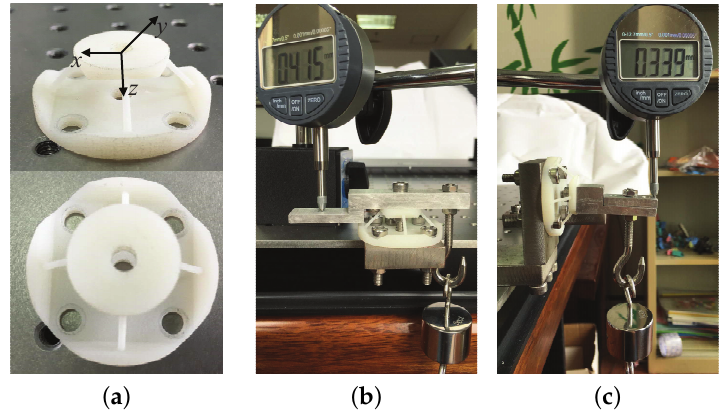
Figure 8. The experimental setups. ( a ) Photo of the prototype, and experimental conditions of ( b ) the first step and ( c ) the second step.